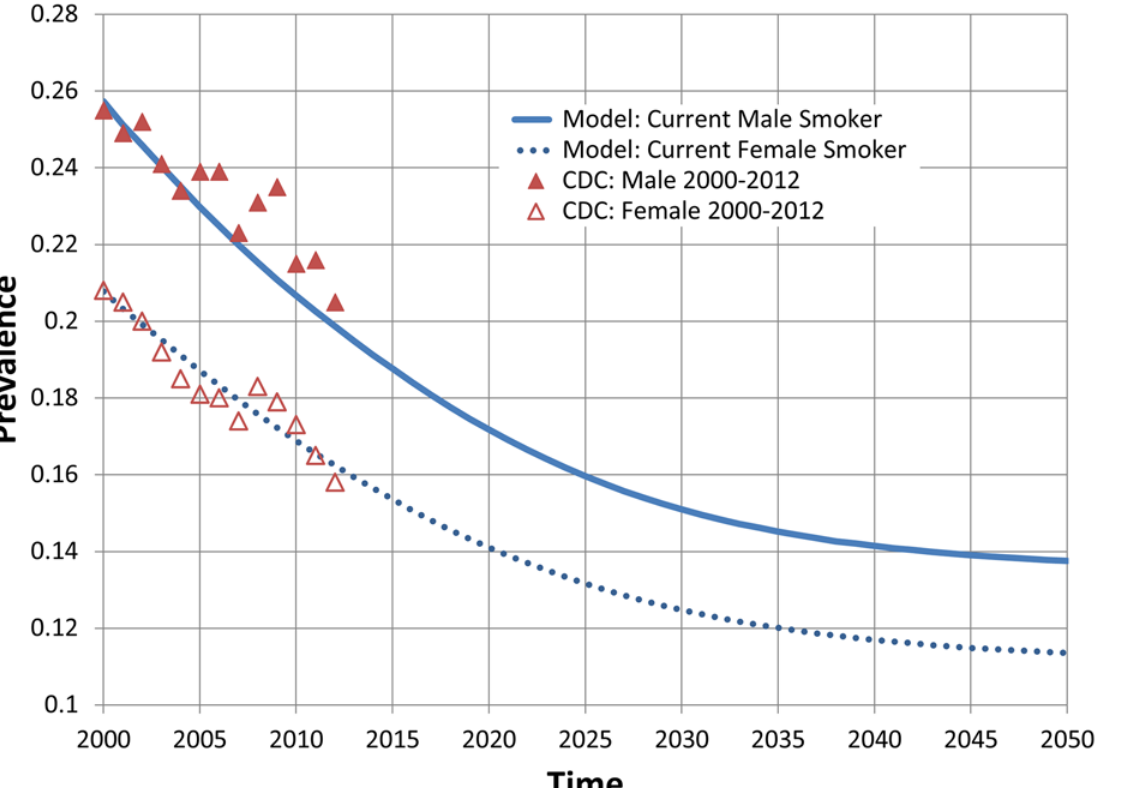
Fig 3. Observed and projected US adult current cigarette smoking prevalence by sex, 2000 –